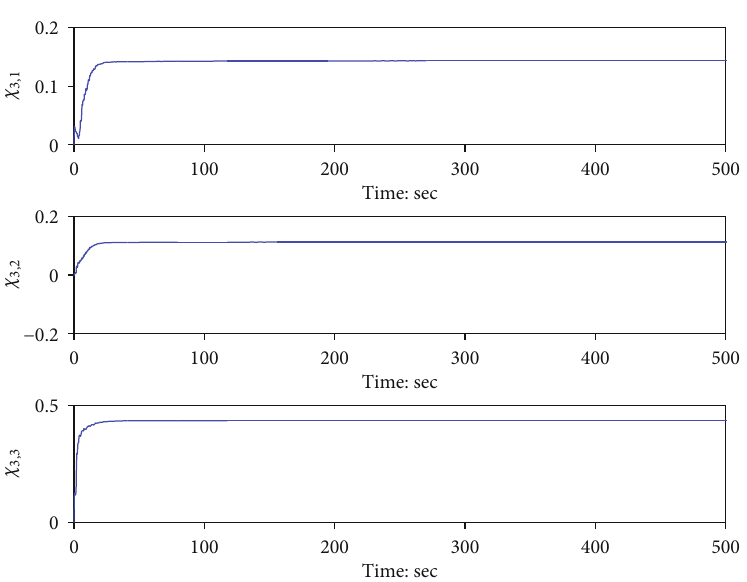
Figure 6: Parameter estimates χ